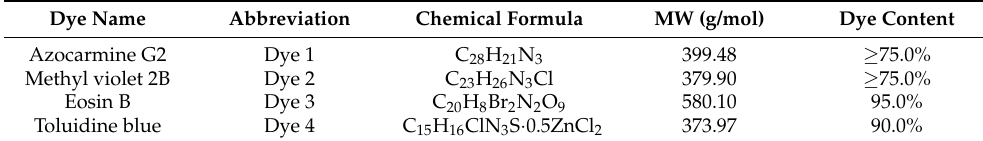
Table 1. Name, abbreviation, dye content, molecular weight, and chemical formula of investi- gated